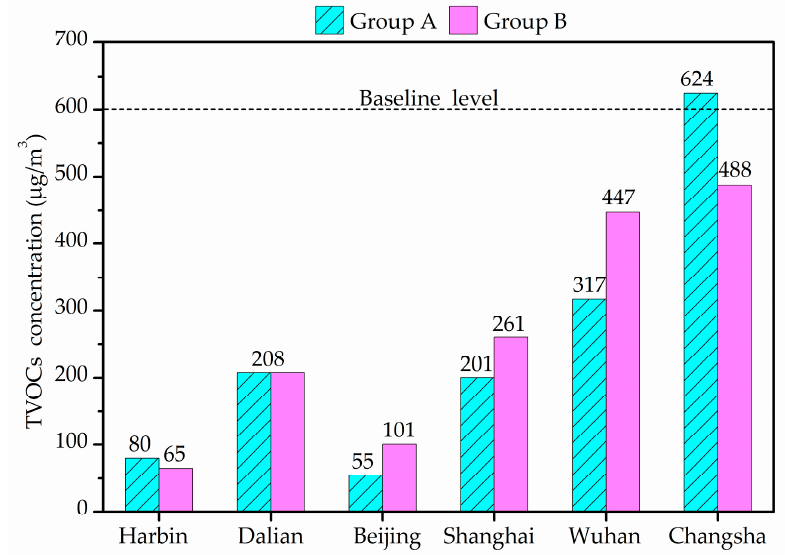
Figure 3. Indoor formaldehyde (HCHO) and acetaldehyde concentrations in winter.